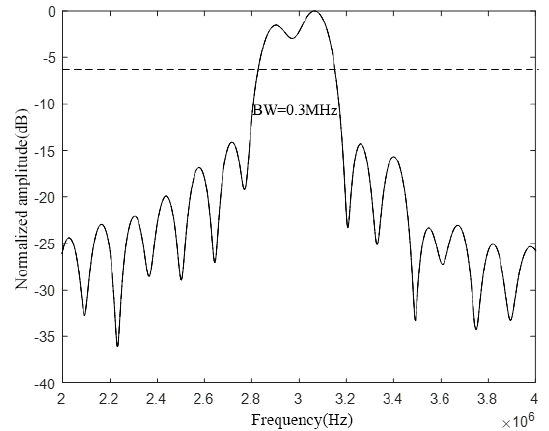
Figure 9. CMUT bandwidth with a cell spacing of 60 μ m.